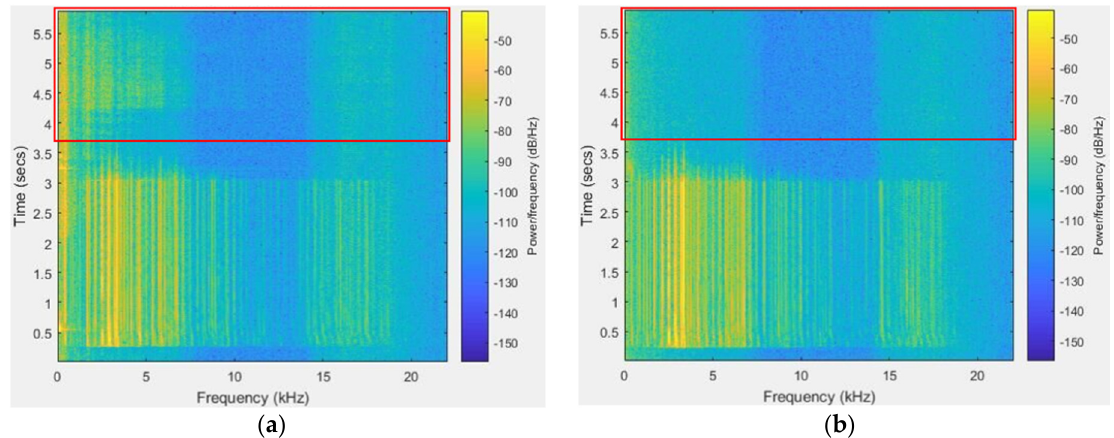
Figure 7. The spectrogram of the sound. ( a ) The spectrogram of the sound we recorded by the sensor in a box; ( b ) the spectrum of the sound we recorded by the sensor towards the outside of the box.